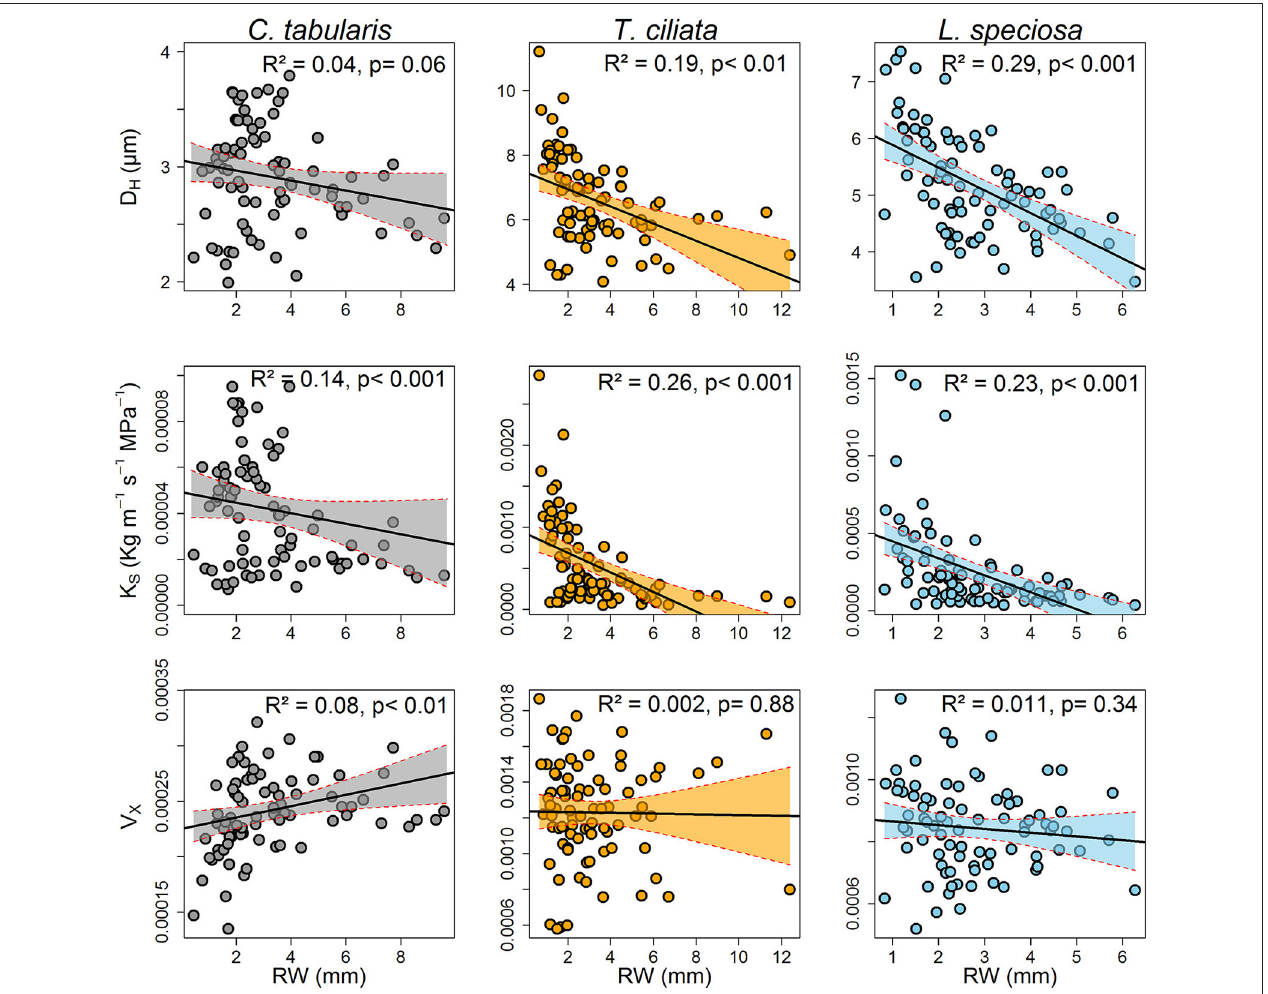
FIGURE 7 | Relationships between ring-width and wood hydraulic traits of three South Asian tropical moist forest tree species. Each data point represents the mean of the respective years of 9 trees. Shaded areas represent 95% confidence